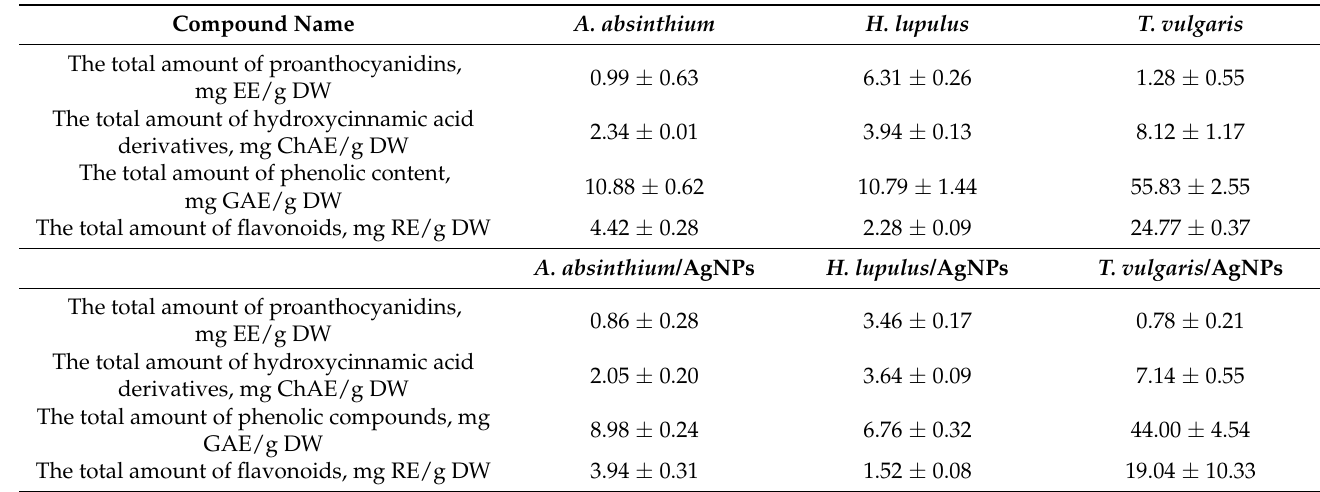
Table 1. Phytochemical analysis of